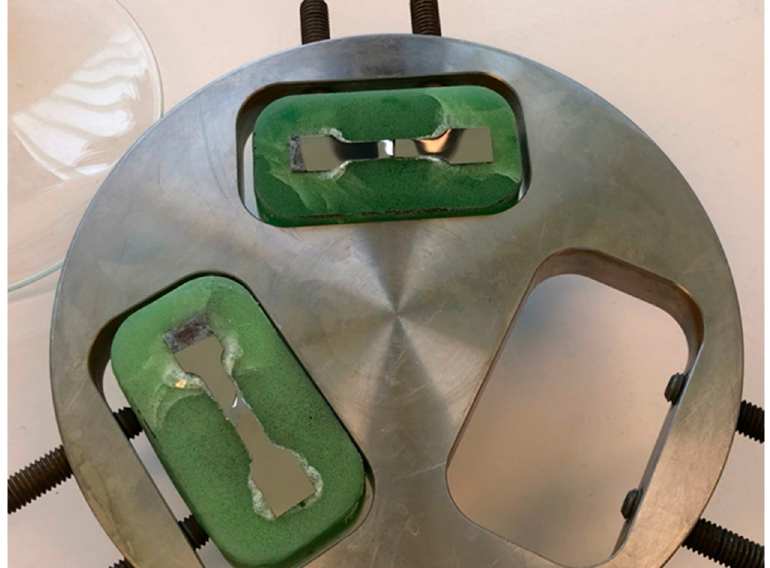
Figure A1. Specimens after polishing in